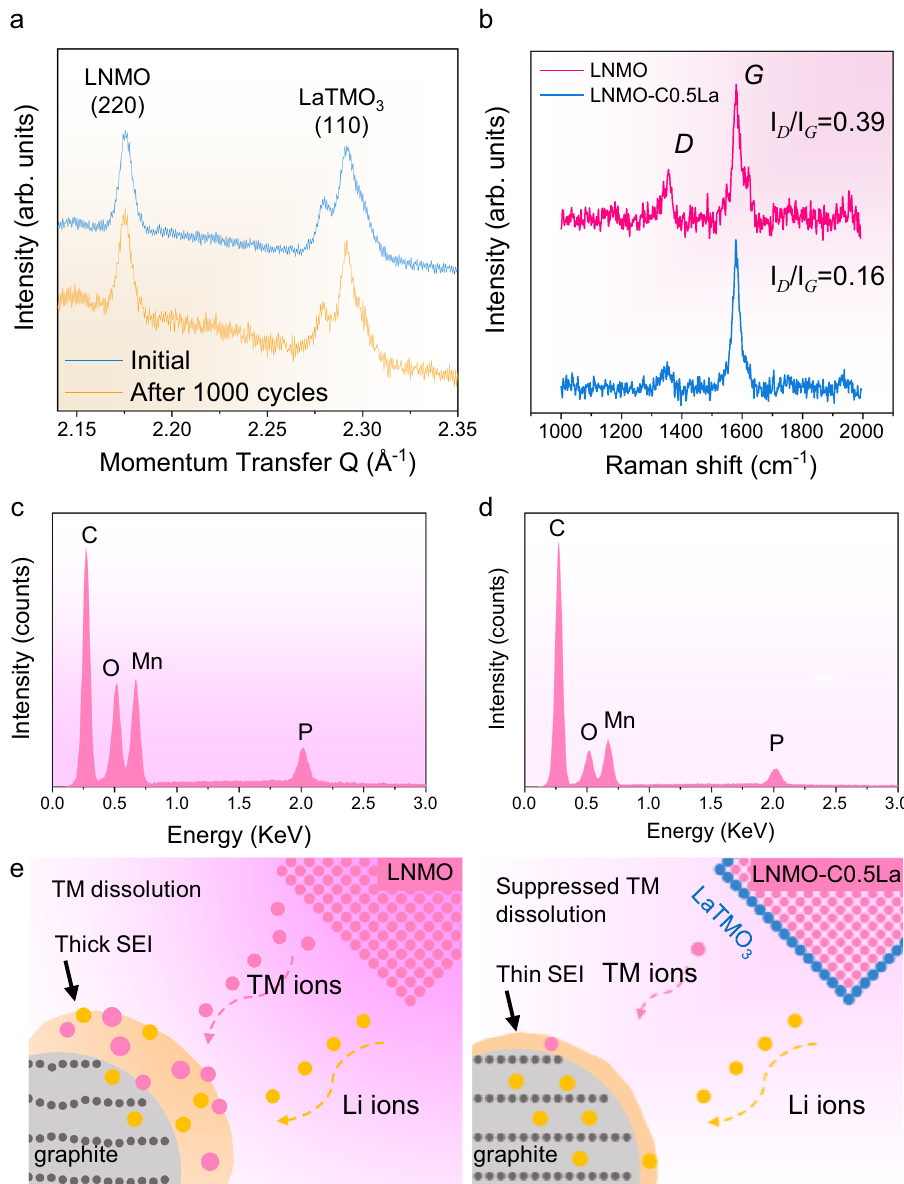
Fig. 6 The role of LaTMO 3 surface protection on the durability of the 5 V-class LIBs. a Ex situ post-mortem Synchrotron XRD measurement showing the LNMO (220) peak and the LaTMO 3 cubic (110) re fl ection for LNMO-C0.5La cathodes before and after cycling in the 3.4 – 4.8 V full cells. b Ex situ post- mortem Raman spectra of the graphite anodes harvested from cycled full cells using LNMO and LNMO-C0.5La cathodes. c , d Ex situ post-mortem EDS spectra of the cycled graphite anodes coupled with LNMO ( c ) and LNMO-C0.5La ( d ). e Schematic of the effect of the suppressed TM dissolution on the preservation of graphite anode. All the electrodes were collected from full cells at discharged state after 1000 cycles at 290 mA g − 1 under 26